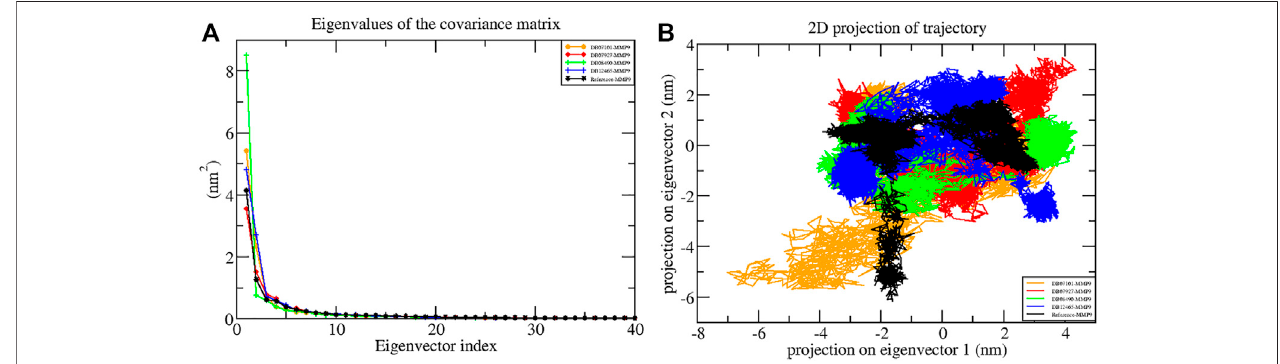
FIGURE 9 | Gibbs energy plot of (A) reference – MMP-9, (B) DB12465 – MMP-9, (C) DB07101 – MMP-9, (D) DB08490 – MMP-9, and (E) DB07927 – MMP-9 complex.